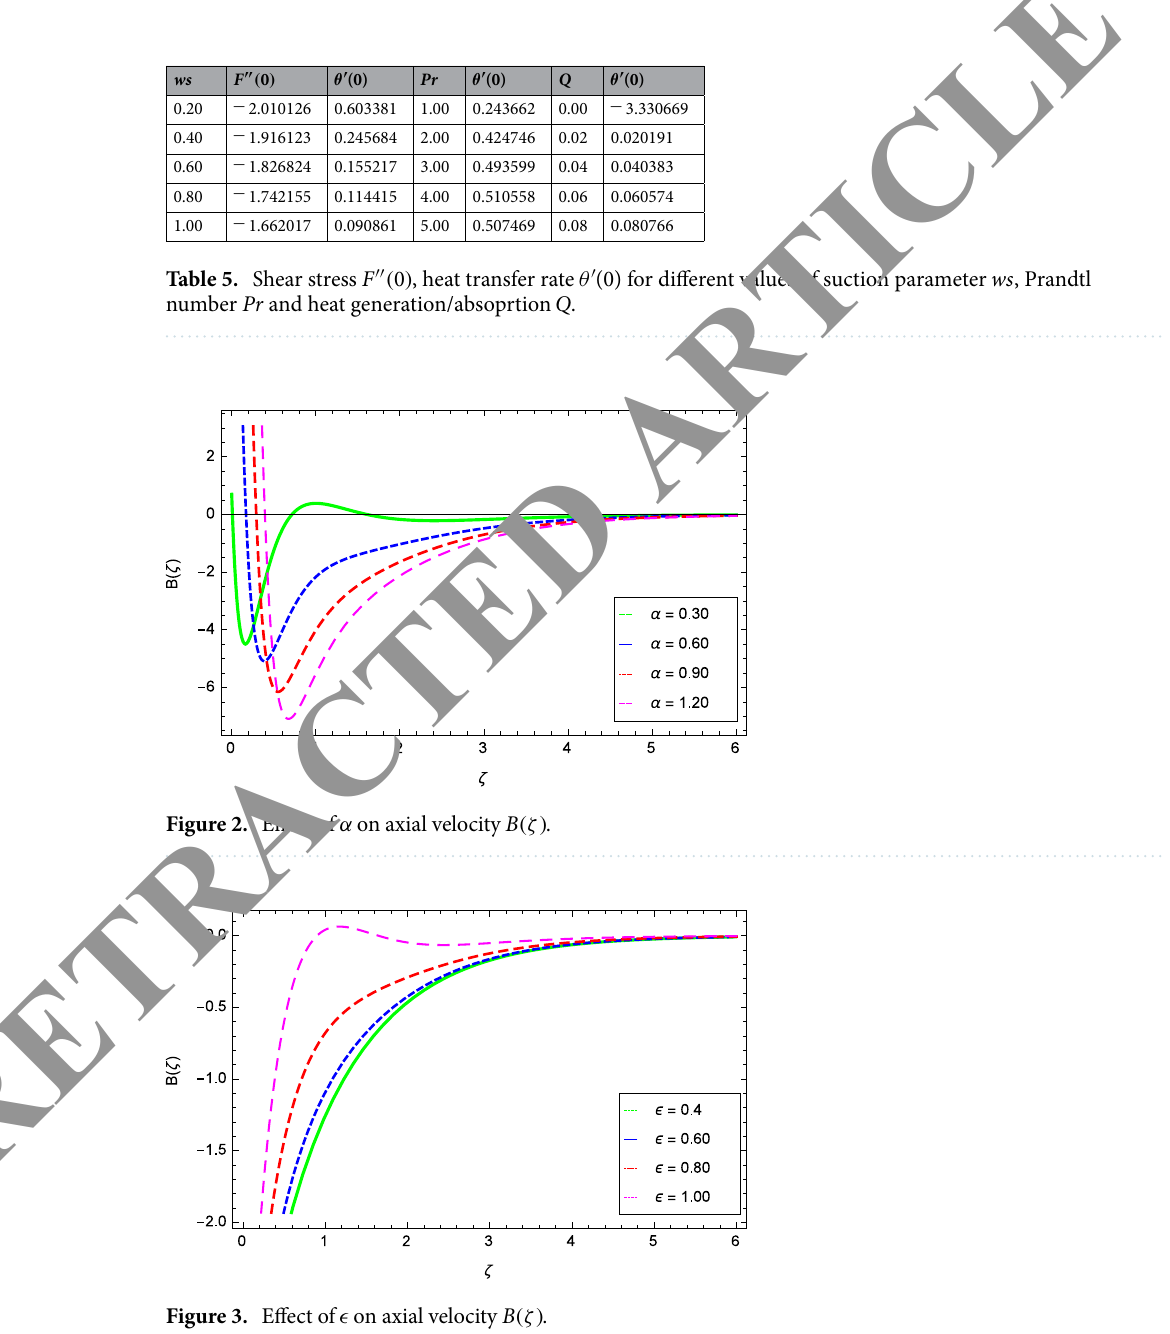
Table 4. Shear stress F ′′ ( 0 ) , heat transfer rate θ ′ (0) for different values of nanoparticles concentration φ and magnetic field parameter M .